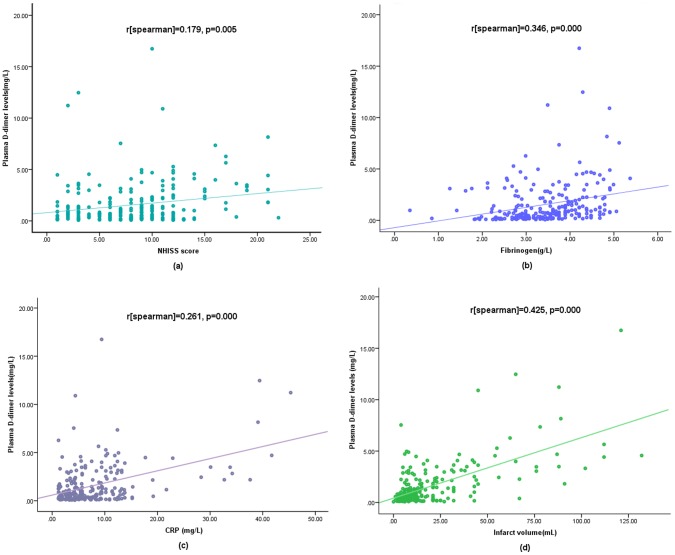
Correlation between plasma D-dimer levels and others predictors.(a) Correlation between plasma D-dimer levels and the National Institutes of Health Stroke Scale (NIHSS) score; (b) Correlation between the plasma D-dimer levels and fibrinogen levels; (c) Correlation between plasma D-dimer levels and CRP; (d) Correlation between plasma D-dimer levels and infract volume.